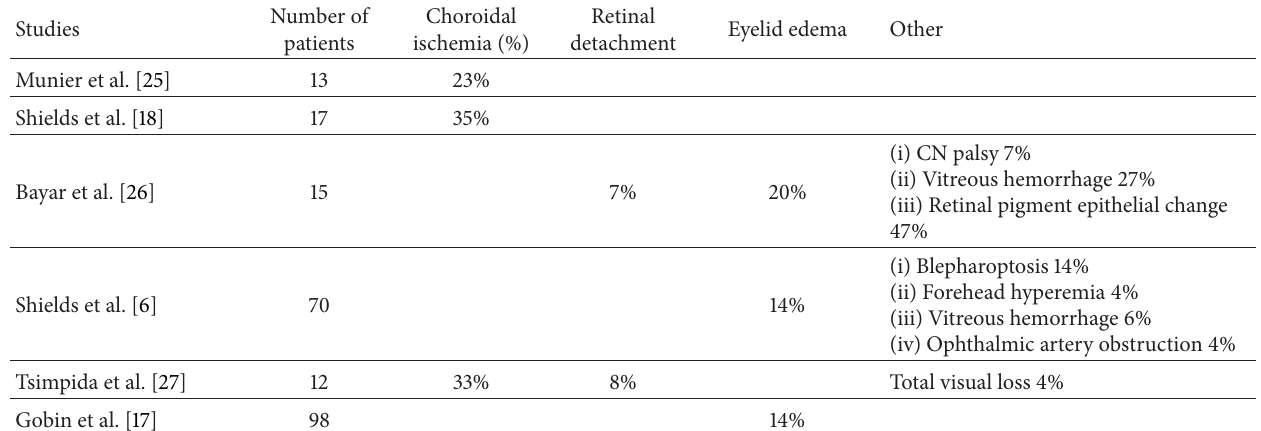
Table 2: Complications of intra-arterial chemotherapy for retinoblastoma in the